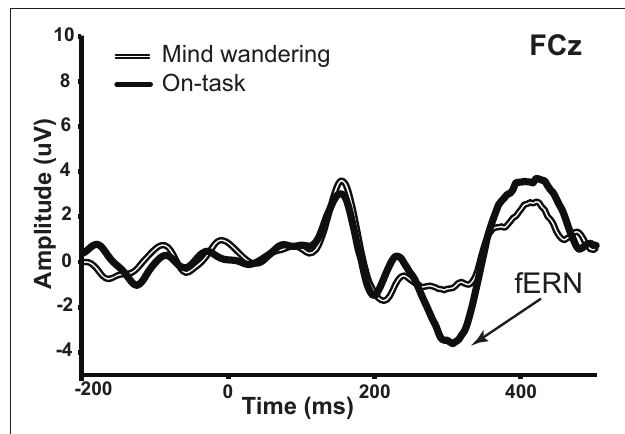
FIGURE 4 | fERN in difference waveforms (error—correct) as a function of on-task vs. mind wandering states. The amplitude of fERN at FCz was significantly attenuated during periods of mind wandering relative to periods of on-task attention.